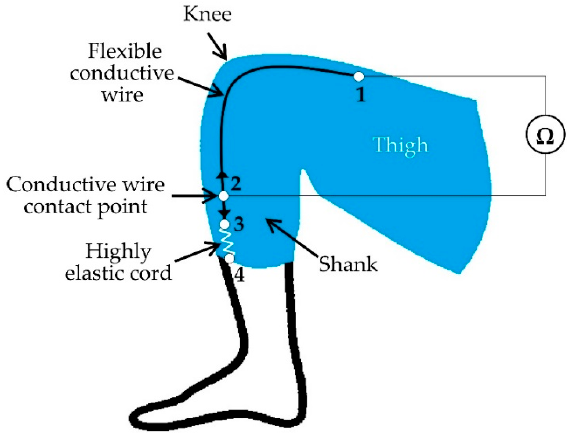
Figure 10. Schematic design of conductive wire sensor-based wearable joint monitoring device.